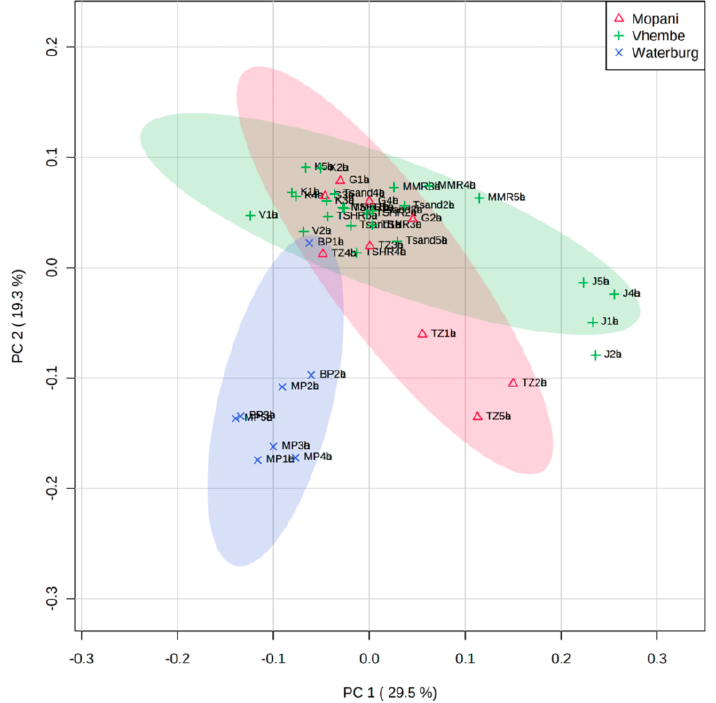
Figure 3. PCA scores plot derived from HPTLC data and coloured according to the three districts where the samples were collected.